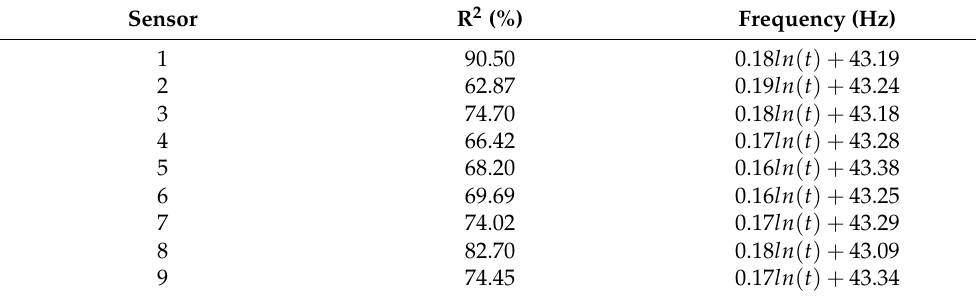
Table 2. Results observed in the correlation between frequency and